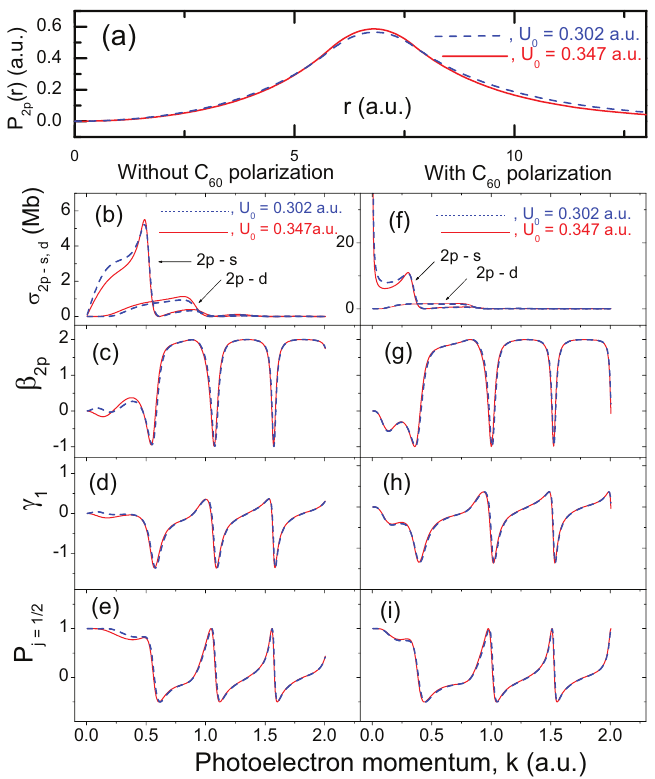
( 2 p ) anion obtained with the use of the depths U Figure A1. Calculated data for a C − 60 a.u. (dashed lines) and 0.347 (solid lines) a.u. for the U C ( r ) pseudo-potential, Equation (9), as marked in the figure. ( a ) The P 2 p ( r ) radial part of the wavefunction of the attached 2 p electron. ( b – e ) Calculated, without account for polarizability of C 60 , σ 2 p → s and σ 2 p → d photodetachment cross sections, β 2 p photoelectron angular-asymmetry parameter, γ 1 spin-polarization parameter and the P angle-integrated degree of photoelectron spin polarization. ( f – i ) The same as ( b – e ) but with j = 1 2 account for polarizability of C 60